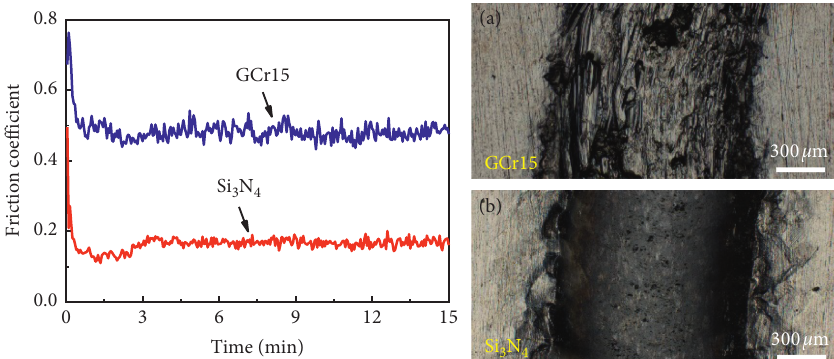
° C and a sliding rate of 3 N 4 or GCr15 balls at a temperature of 250